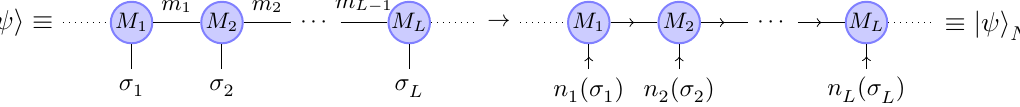
Figure 3: Schematic of the tensor network of a MPS. Horizontal lines denote the internal indices with bond dimension m , whereas the vertical lines denote physical j indices with dimension d . Dotted lines to the left and right indicate the dummy indices m and m L 0